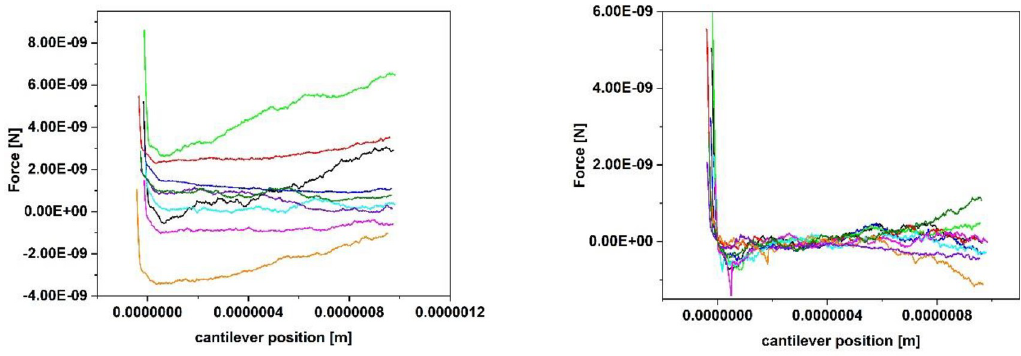
Fig 3. 10 typical force-distance curves (left trace, right retrace., the baseline of all the retrace curves was set to 0 nN) of a single Lactococcus lactis cell on glass, recorded with the following parameters: Setpoint 2 nN, z-length 1 μ m, z-speed 2 μ m/ s, pause time 10